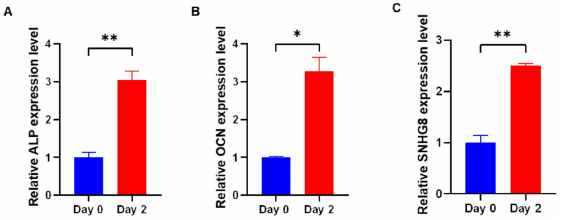
Figure 1. The expression of SNHG8 increased in osteogenic medium. For the induction of osteoblast differentiation, PDLSCs were cultured in osteogenic medium (OM), which was composed of growth medium supplemented with b-glycerophosphate (10 mM), dexamethasone (100 nM) and vitamin C (200 mM). The relative mRNA expression of ( A ) alkaline phosphatase (ALP), ( B ) osteocalcin (OCN) and ( C ) small nucleolar RNA host gene 8 ( SNHG8 ) was measured by qRT-PCR on the second day of osteogenic induction. Three repeated experiments were conducted. Data are presented as the mean ± SD, * p < 0.05, ** p <